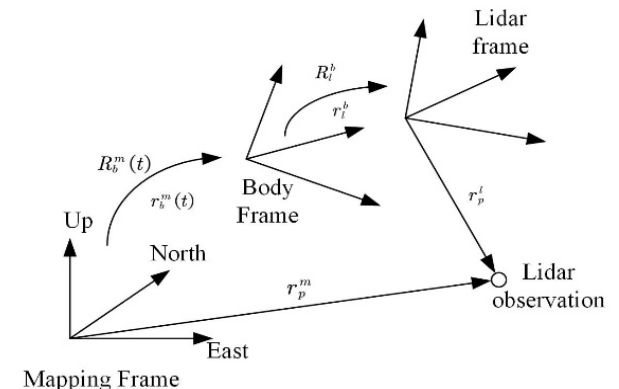
Figure 2. 3D mapping frame involved in the helmet-based laser scanning system.